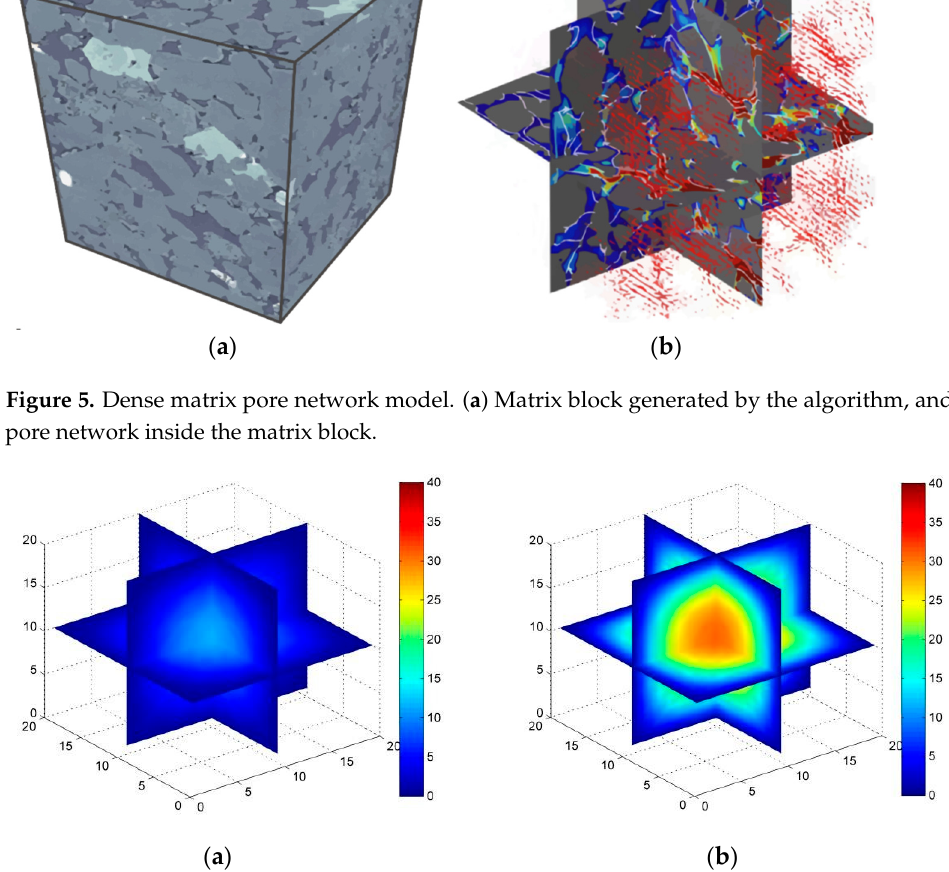
Figure 6. Example of pressure field simulation in a depletion process. ( a ) Pressure distribution (3 days), and ( b ) pressure distribution (6 days).